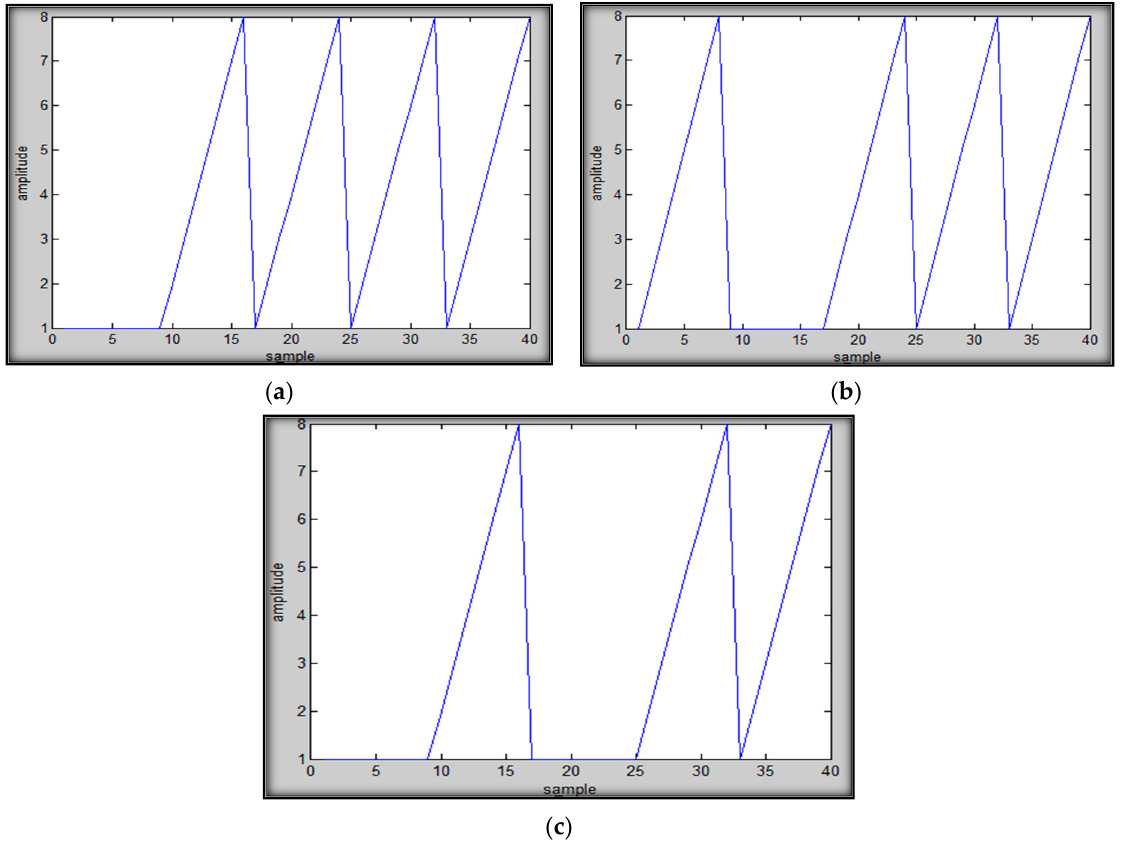
Figure 11. Delay at both ends (Tx and Rx). ( a ) Delay Tx (at the beginning), delay Rx (at the beginning) ( b ) delay Tx (in between), delay Rx (in between), ( c ) delay Tx (both (( a ) and ( b ) cases)), delay Rx (both (( a ) and ( b ) cases)).